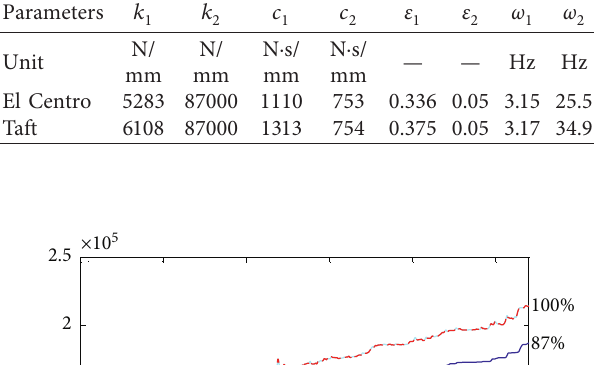
� 2.84s, μ � 0.05, and the g